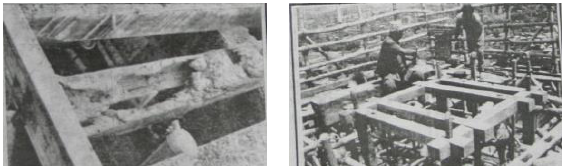
Figure 11. Replacement of decayed timber during 1996